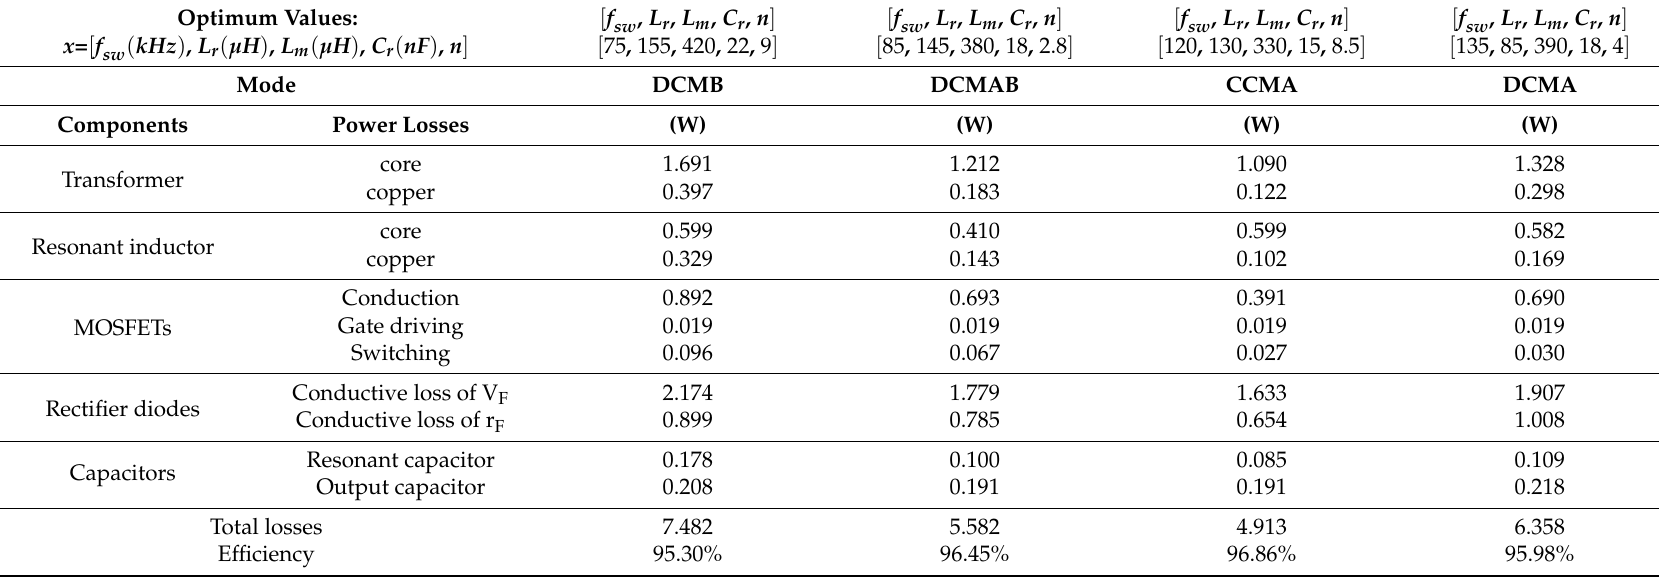
Table 8. Losses Profile of LLC resonant converter by Monte Carlo optimization